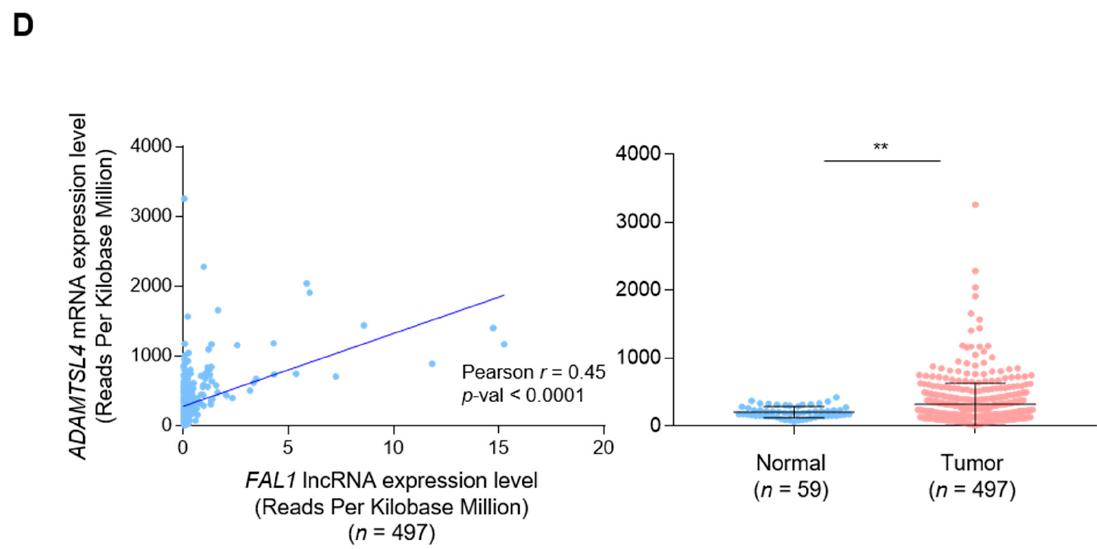
Figure 1. ( A ) Positive correlation of FAL1 expression with the expression of neighbouring genes adjacently located on chromosome 1q21.3. A. FAL1 expression status of 20 types of human cancers. ( B ) Location of FAL1 and neighbouring genes on chromosome 1q21.3 and correlation status of FAL1 with neighbouring genes in terms of expression in 17 human cancers. ( C ) Positive correlation of FAL1 expression and ECM1 expression, and upregulated expression of ECM1 in tumour samples compared to that in normal tissues in THCA. ( D ) Positive correlation of FAL1 expression with ADAMTSL4 expression and upregulated expression of ADAMTSL4 in tumour samples compared to that in normal tissues in THCA. Abbreviations: FAL1 , focally amplified lncRNA on chromosome 1; RPRD2, regulation of nuclear pre-MRNA domain-containing 2; TARS2, threonyl-tRNA synthetase 2, mitochondrial; ECM1 , extracellular matrix protein 1; ADAMTSL4 -AS1, ADAMTSL4 antisense RNA 1; MCL1, myeloid cell leukaemia 1; ENSA, endosulfine alpha; GOLPH3L, Golgi phosphoprotein 3-like; HORMAD1, HORMA domain-containing 1; CTSS, cathepsin S; CTSK, cathepsin K; ARNT, aryl hydrocarbon receptor nuclear translocator. The arrows indicate the direction of transcription. Average values were compared using an unpaired t-test. In the scatter plots, data are expressed as the mean ± SD. Correlation coefficient: Pearson’s r. * p < 0.05, ** p < 0.01. All p -values are two-sided.